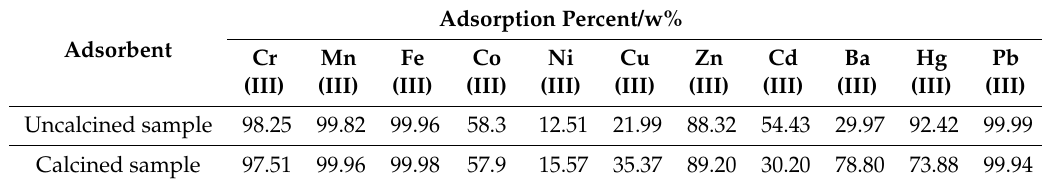
Table 5. Adsorption percentage of metal ions on the lanthanum phosphate in 3 mol L − 1 of ammonia.